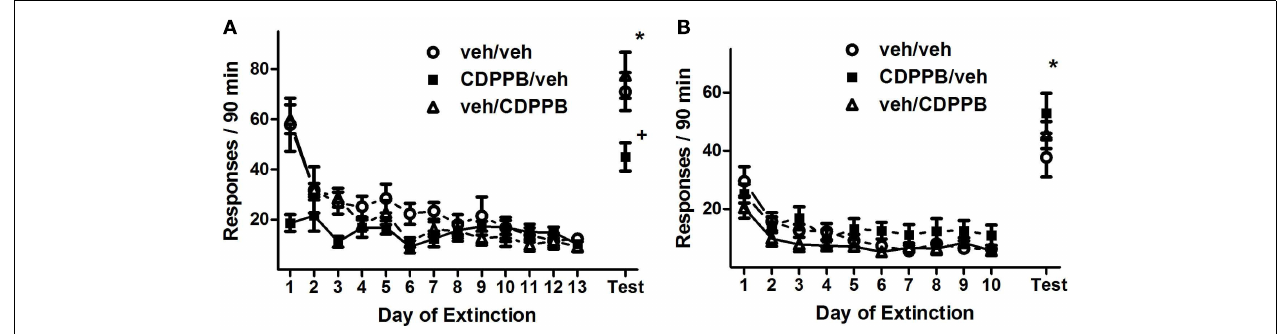
test session. Filled symbols indicate pretreatment with 30mg/kg CDPPB on Days 1–7, and open symbols indicate corresponding vehicle treatment. * p < 0.05 difference between reinstatement testing and average of final two extinction sessions, in all treatment groups (paired t -tests). + p < 0.05 difference between CDPPB/veh group and both veh/veh and veh/CDPPB groups (paired t